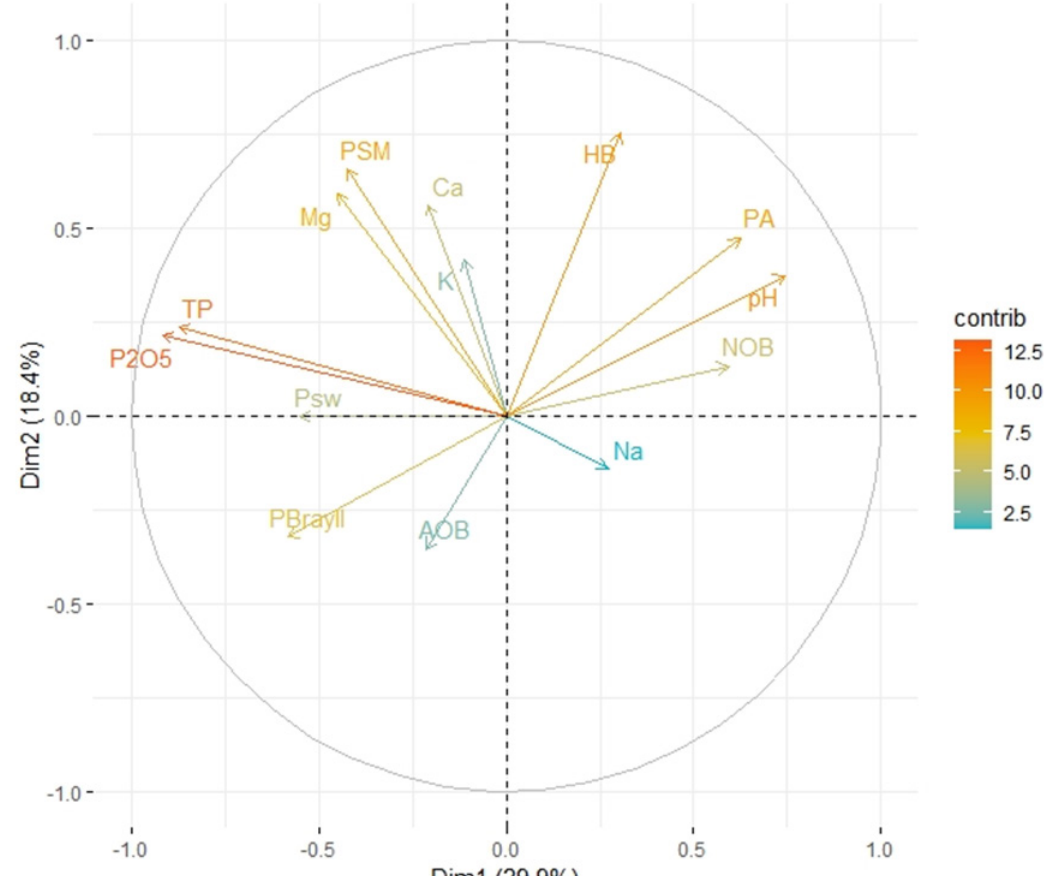
Fig. 6 Analysis of main components in manures composting with different PR